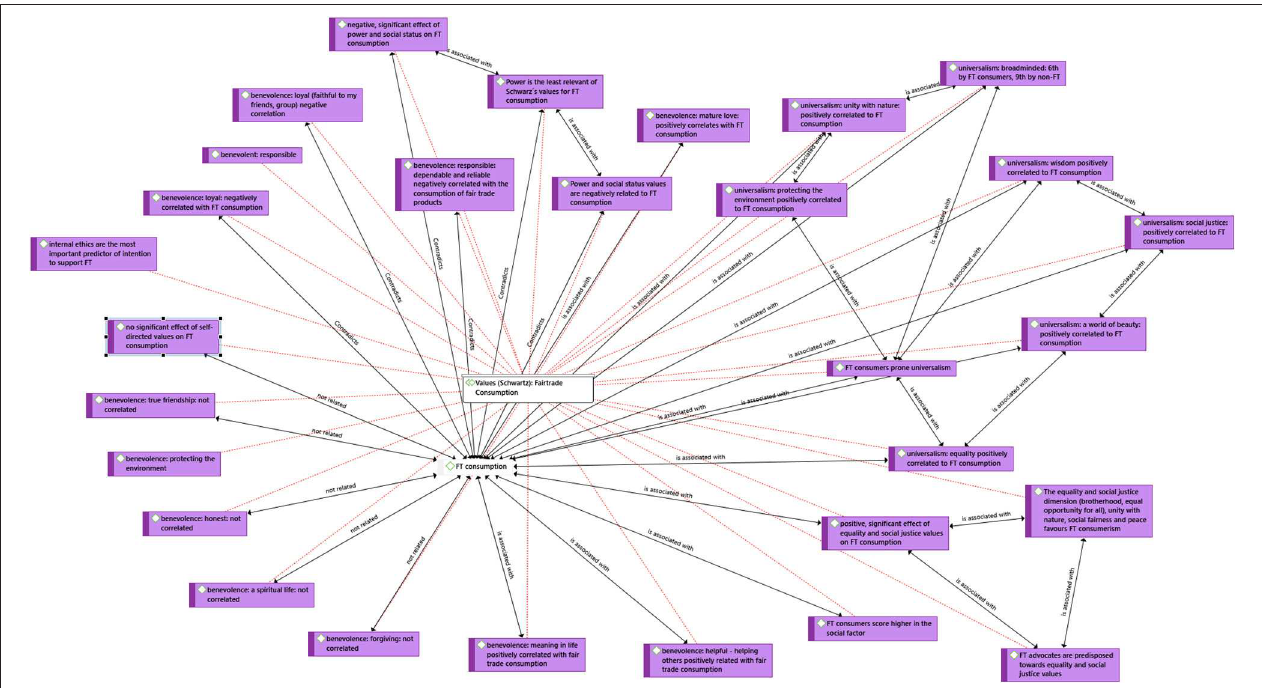
FIGURE 3 | Network analysis: